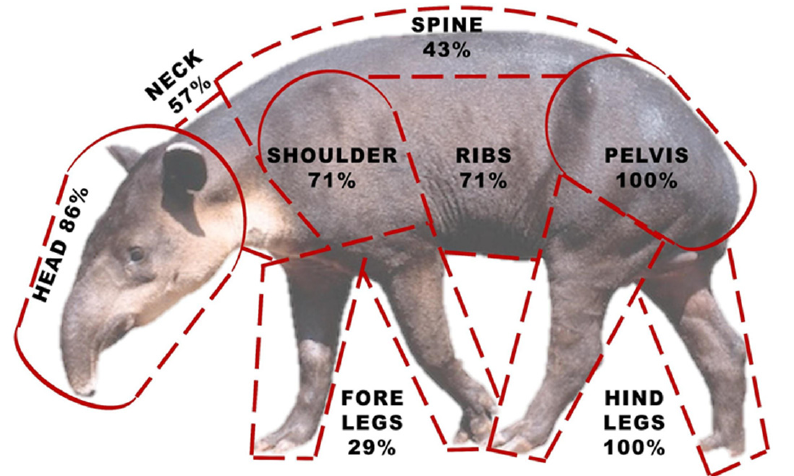
Figure 4. Division of the body into eight anatomical regions to determine the pattern of injuries: head, neck, shoulder, forelegs, spine, ribs, pelvis and hindlegs. It also shows the frequency of injuries observed in tapirs presumably attacked by jaguars in Calakmul, Mexico.